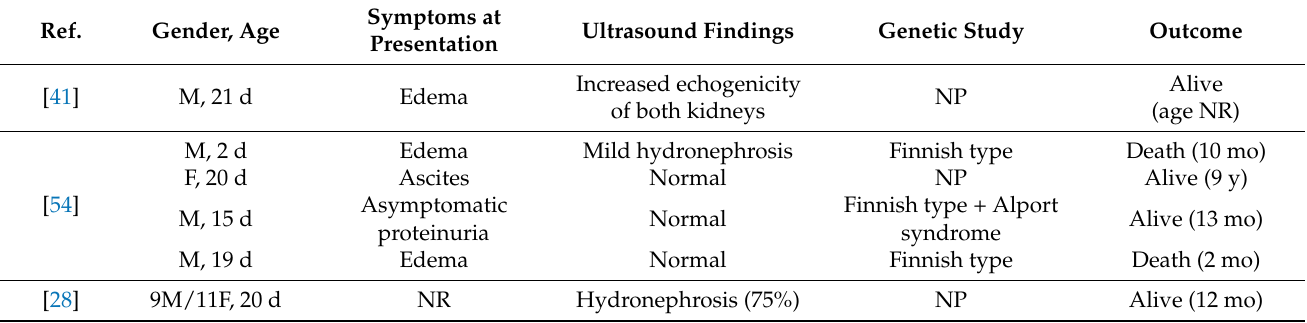
Table 4. Clinical details of the infants with cCMV infection and congenital nephrotic syndrome.